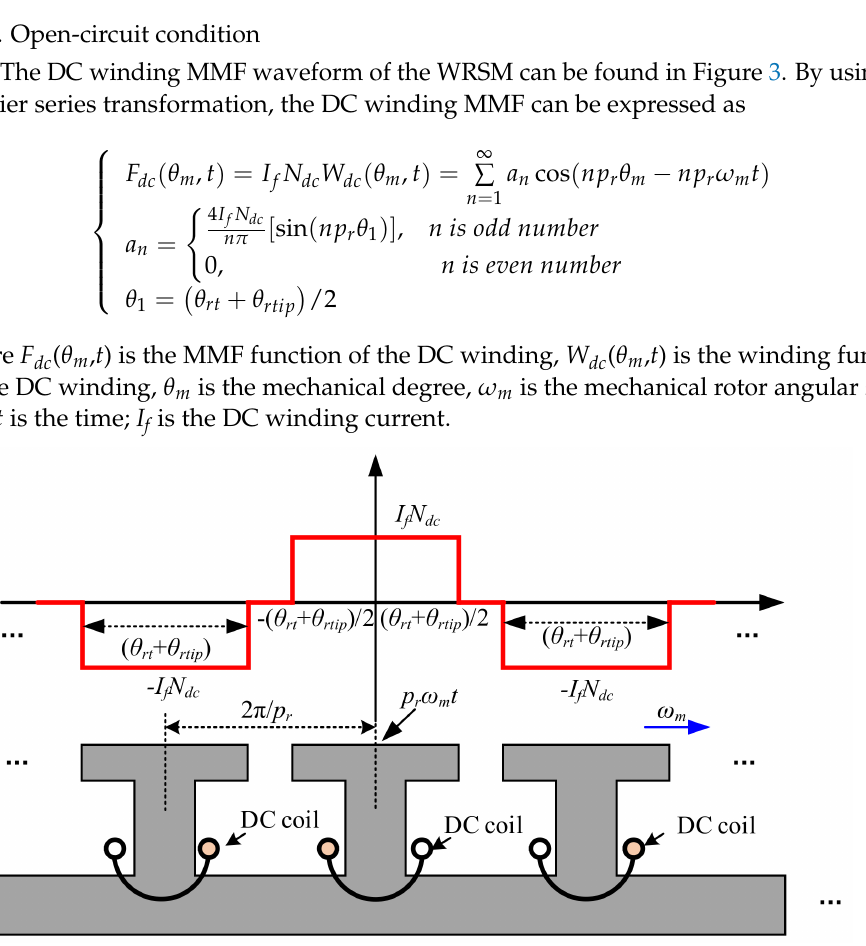
Figure 3. DC winding MMF waveform of the